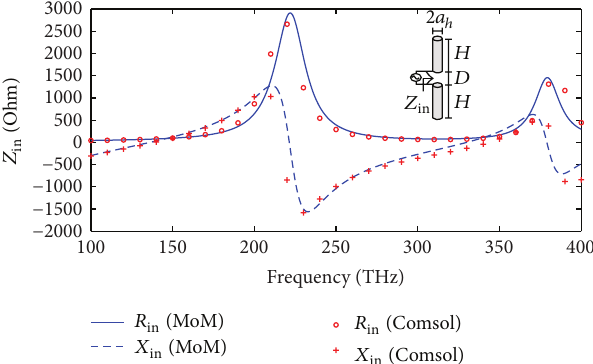
Figure 6: Input impedance of isolated nanodipole with 𝐿 = 0 nm, = 220 nm, 𝑎 = 𝑎 = 10 nm, and 𝐷 = 20 nm. 𝐻 = ℎ+𝑎 𝐿 𝐿 ℎ